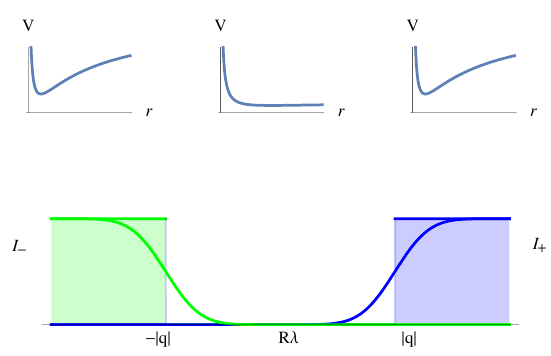
Figure 1 . Top: radial potential V for R(cid:21) < (cid:0)j q j , (cid:0)j q j < R(cid:21) < j q j , and R(cid:21) > j q j , respectively. BPS bound states exist only for R j (cid:21) j > q . Bottom: indices I (cid:6) and b I (cid:6) ( (cid:12) ) as functions of R(cid:21) , for a (cid:12)xed value of the inverse